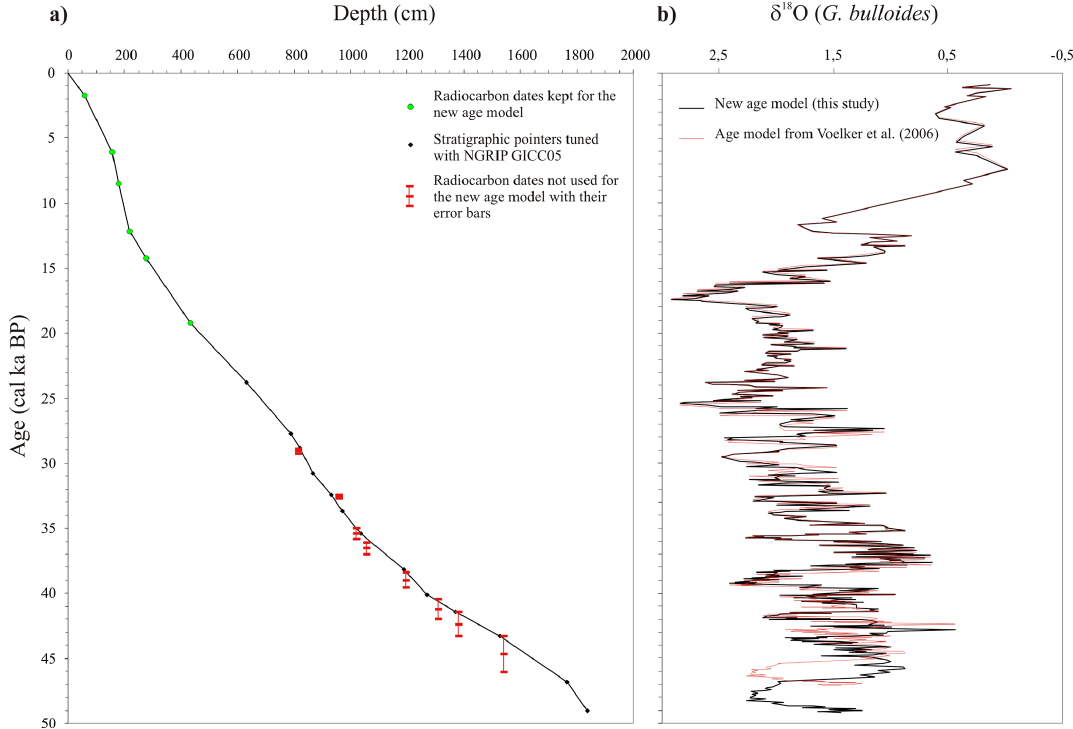
Figure 2. (a) Age–depth model for core MD99-2339 (all symbols are explained in the figure), allowing for comparison of (b) the new age model (this study: planktonic δ 18 O monospecific record in black) with the first published one (Voelker et al., 2006: planktonic δ 18 O record in